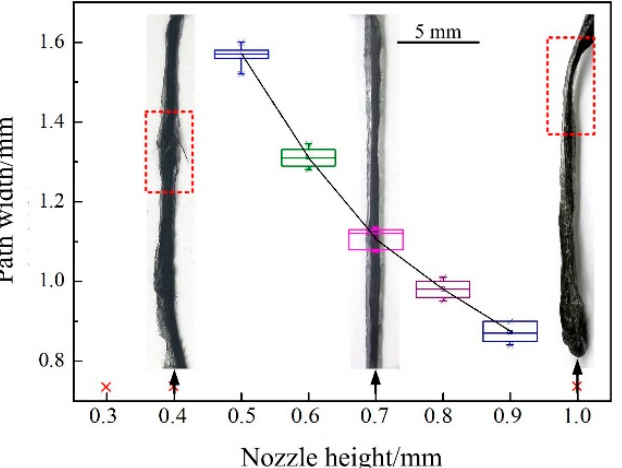
Figure 6. Single channel deposition path width and its resulting image for different nozzle heights. When the height of the nozzle was small (0.3~0.4 mm), the deposition path was uneven, resulting in poor uniformity of the path and carbon fiber that is easy to scrape off. When the nozzle height was extended (1 mm), the extruded composite could not